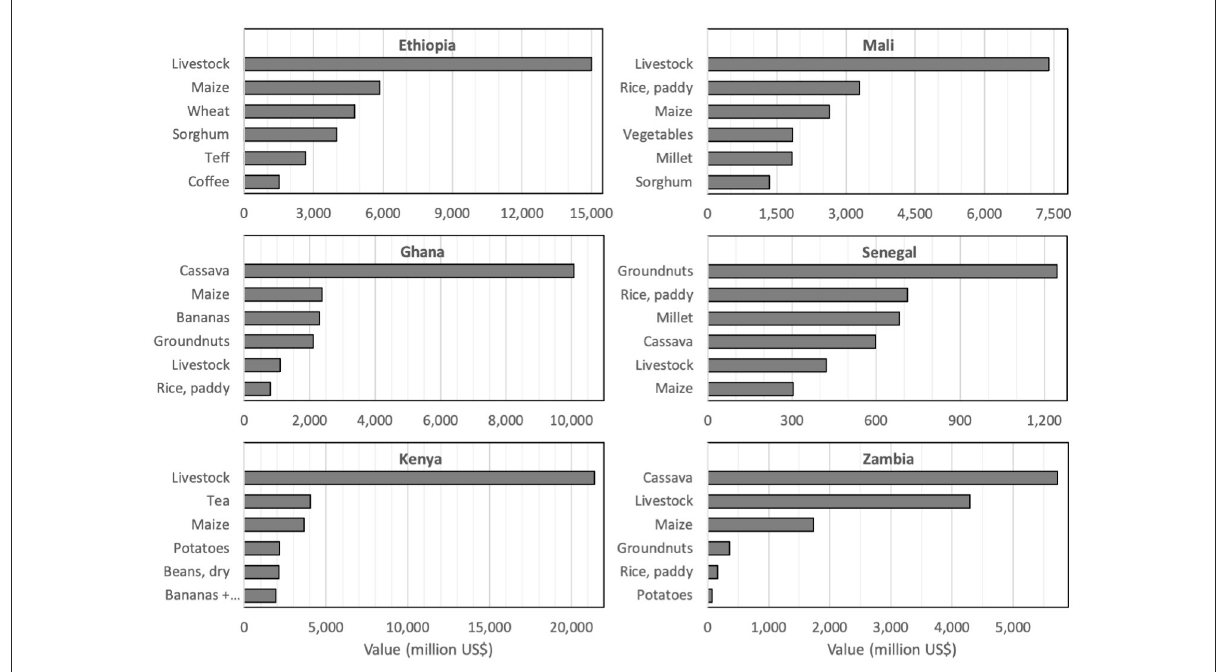
FIGURE2 Top six agricultural value chains in each AICCRA country, based on value, 2016–2019 average. Source: